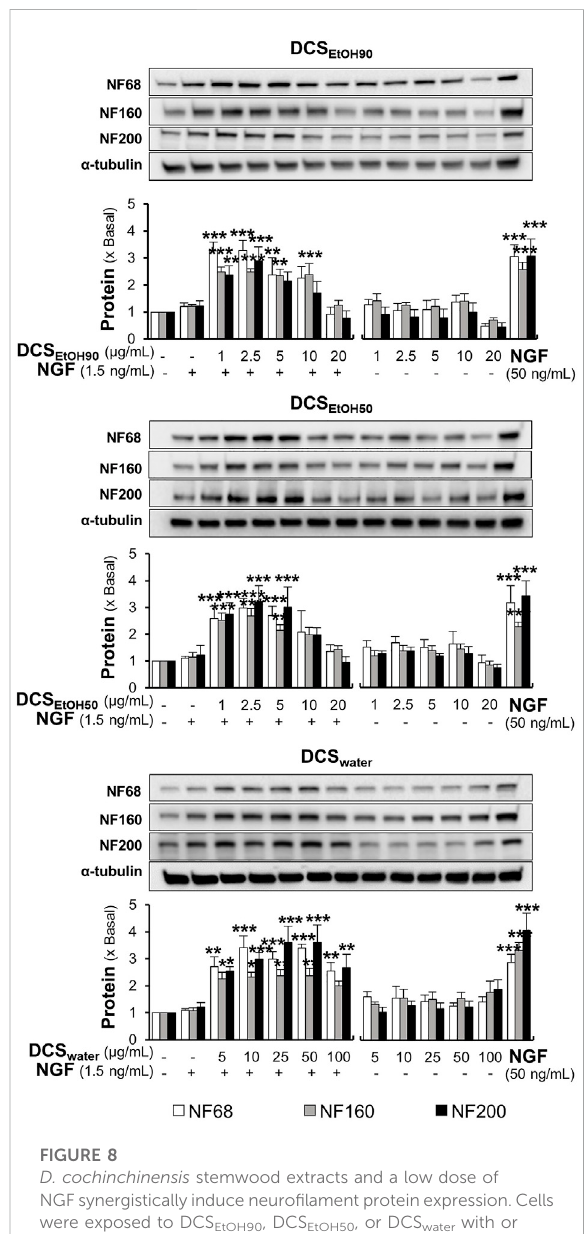
FIGURE 8 D. cochinchinensis stemwood extracts and a low dose of NGF synergisticallyinduce neuro fi lament proteinexpression.Cells were exposed to DCS EtOH90 , DCS EtOH50 , or DCS water with or without 1.5 ng/ml NGF for 48 h. Cells were lysed and the amount of neuro fi lament protein, i.e., NF68, NF160, and NF200, was quanti fi ed by Western blotting. The data are demonstrated as foldchangeofmean±SEM,n=4.* p < 0.05,** p < 0.01,and*** p < 0.001 as compared to the untreated